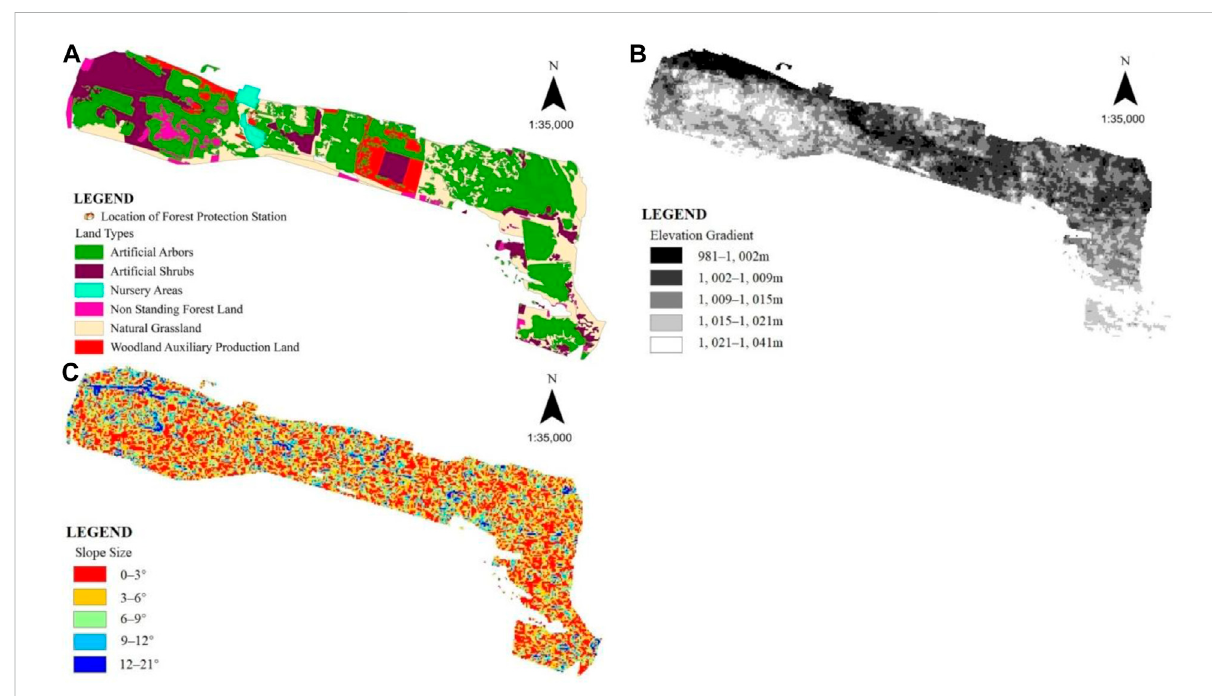
FIGURE 1 Distributions of (A) vegetation resources, (B) elevation gradient, and (C) slope size in the Caositan Forest Protection